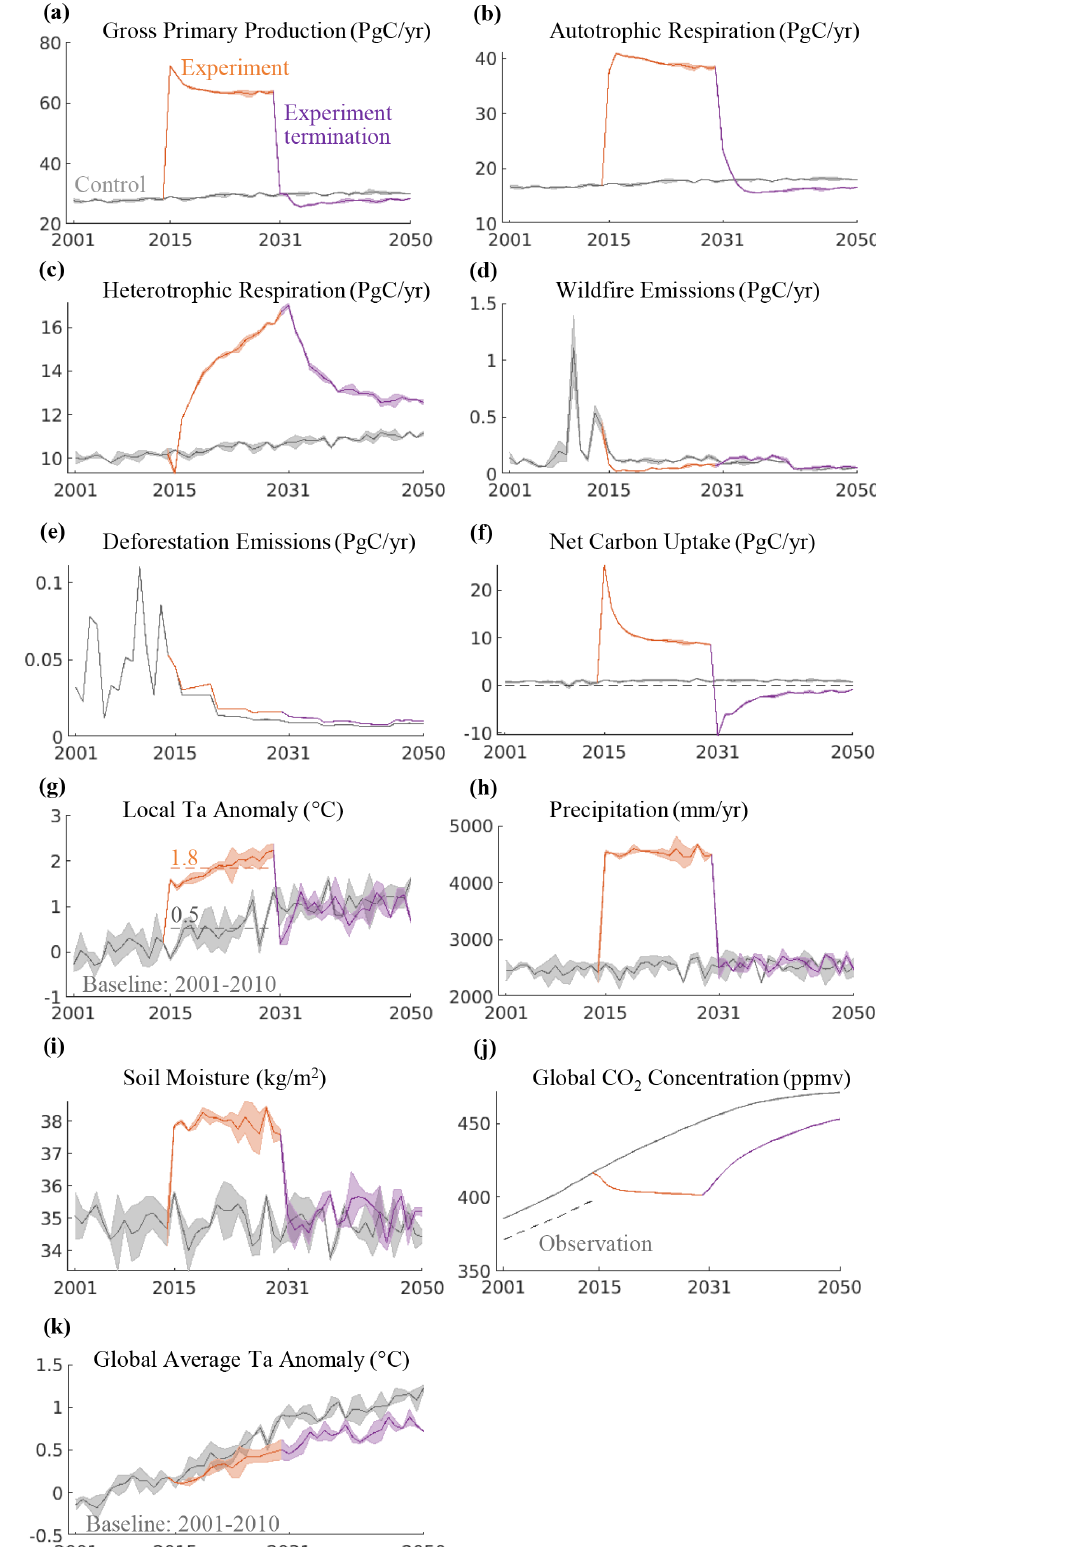
Figure 2. Global tropical forest carbon flux and climate responses during and after the lighting experiment. “Ta” in panels (g, k) repre- sents near-surface air temperature. Soil moisture in panel (i) refers to the mass of water in the 10cm soil surface. Shaded areas represent